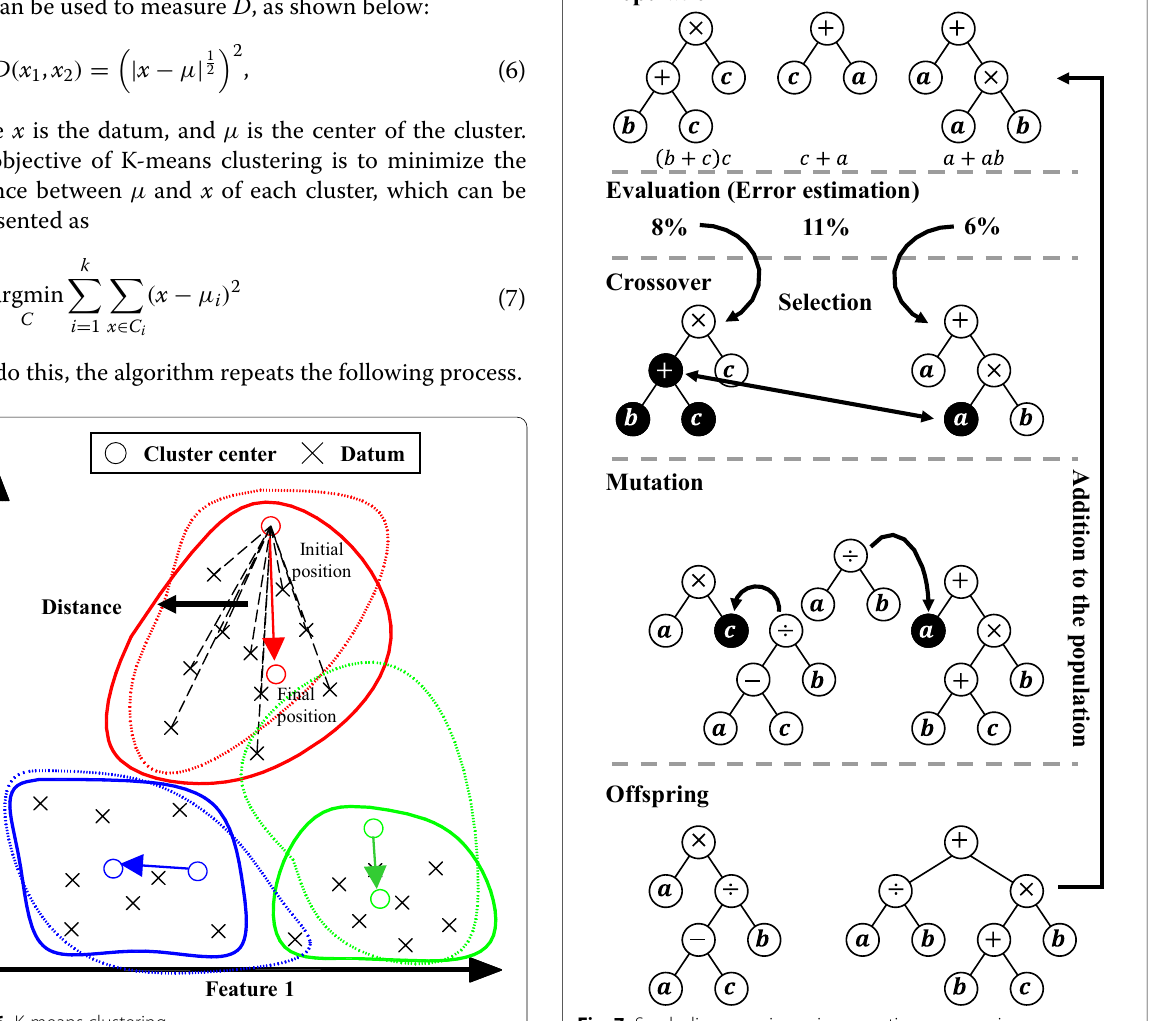
Fig. 6 K‑means clustering. Fig. 7 Symbolic regression using genetic